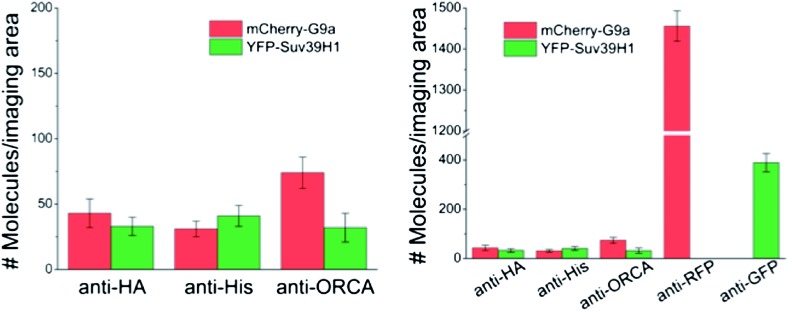
DOI:
http://dx.doi.org/10.7554/eLife.06496.023